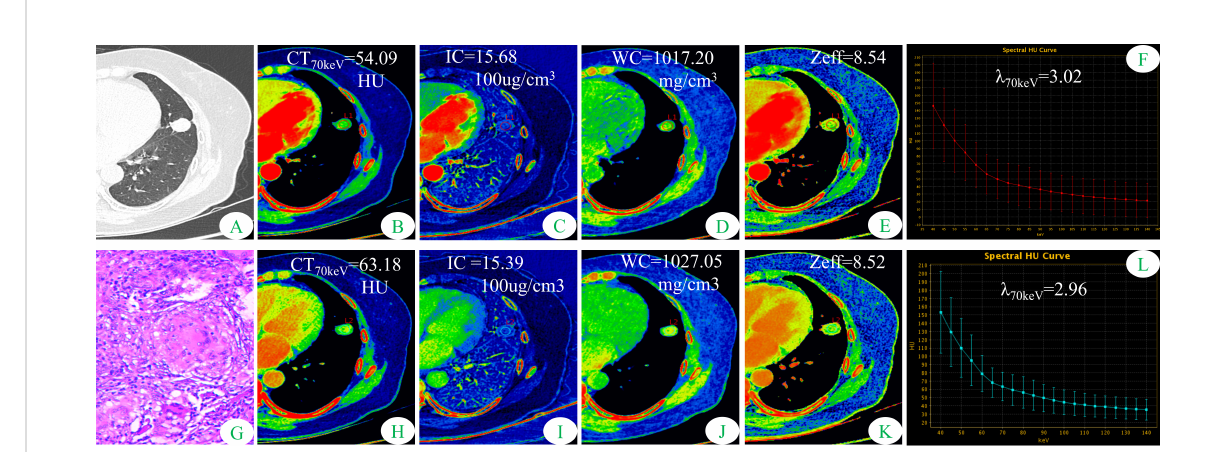
FIGURE 1 Dual-energy spectral CT images and pathological sections of a 51-year-old woman with solitary pulmonary tuberculosis (SP-TB). (A) lung window; (B, H) 70keV single-energy pseudo-color images; (C, I) iodine concentration (IC) pseudo-color images; (D, J) water concentration (WC) pseudo-color images; (E, K) effective atomic number (Zeff) pseudo-color images; (F, L) spectral curves and slopes; (G) hematoxylin and eosin staining (original magni fi cation × 200). (B – F) arterial phase; (H – L) venous